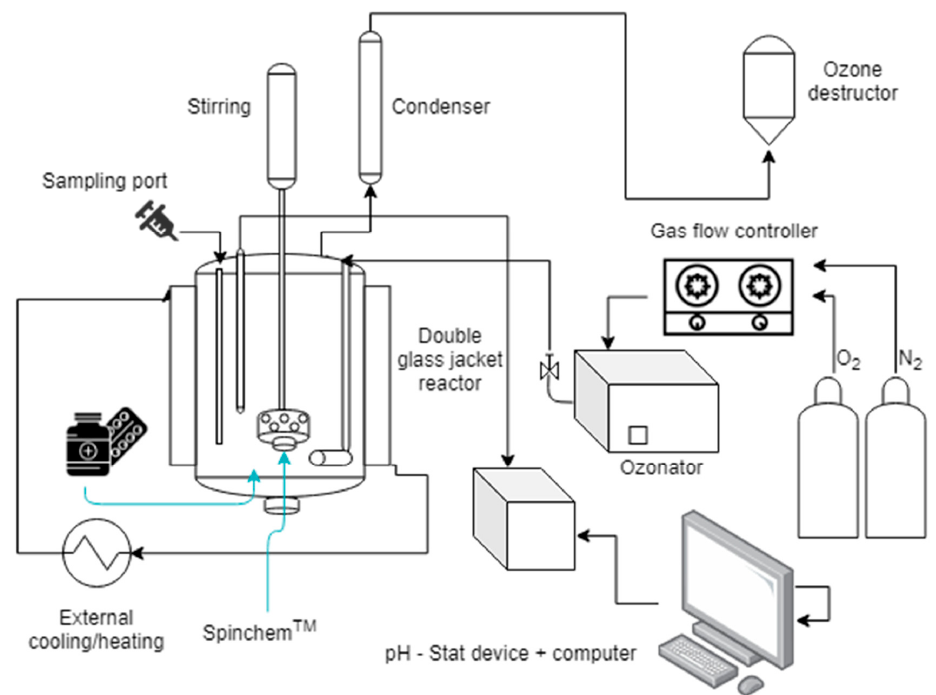
Figure 14. Schematic view of the semi-batch reactor system for degradation of CBZ.